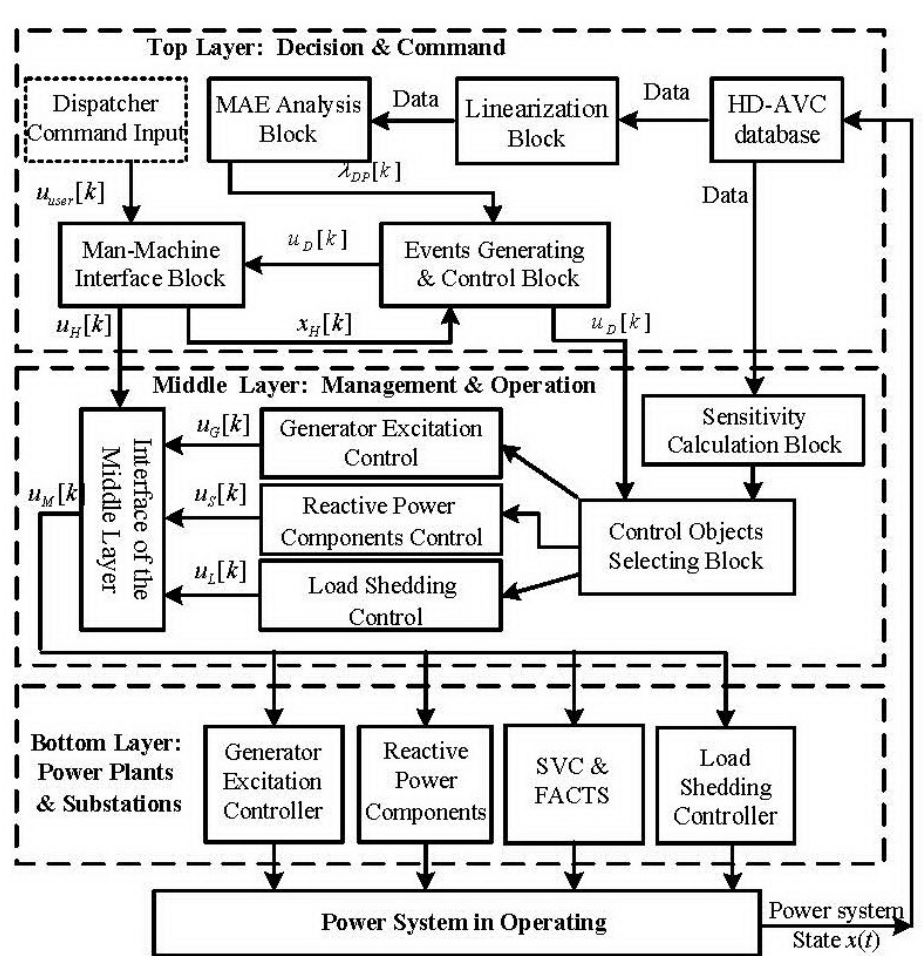
Figure 1. HD-AVC system